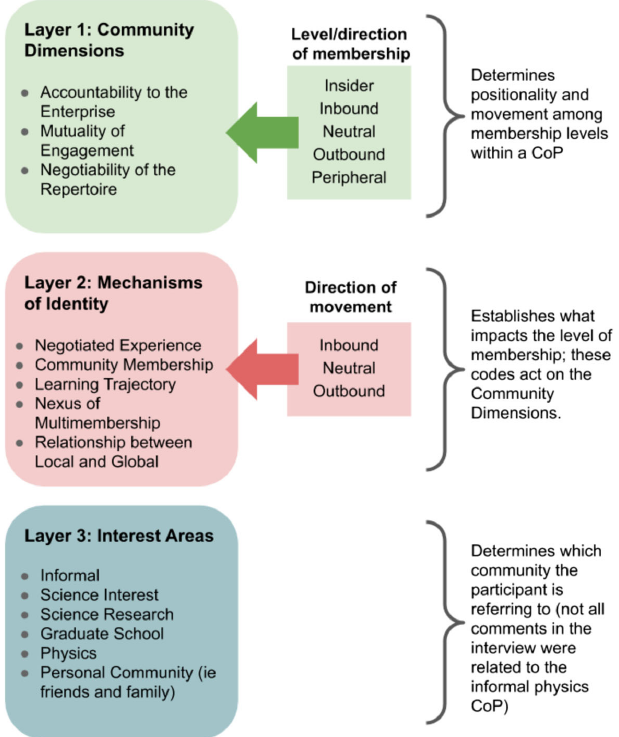
FIG. 1. Depiction of three main layers of our